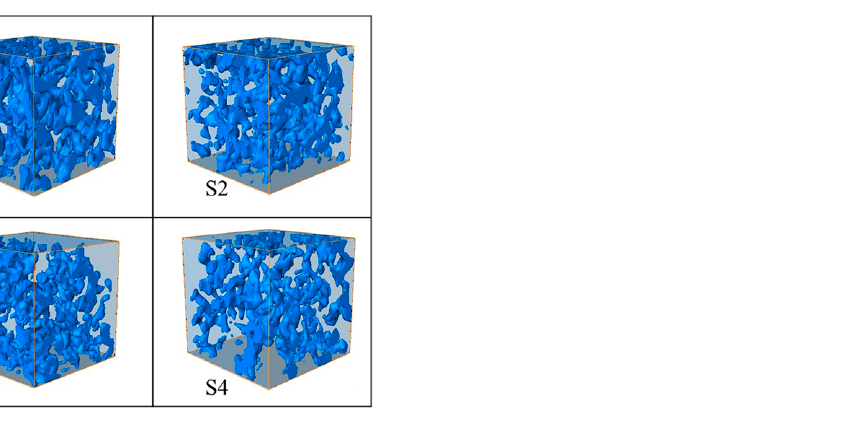
Figure 7. Porosity concentration distribution curve.